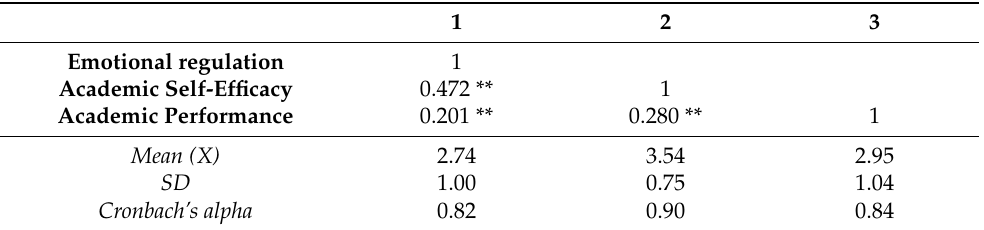
Table 3. Correlational analysis between emotional regulation, self-efficacy and academic